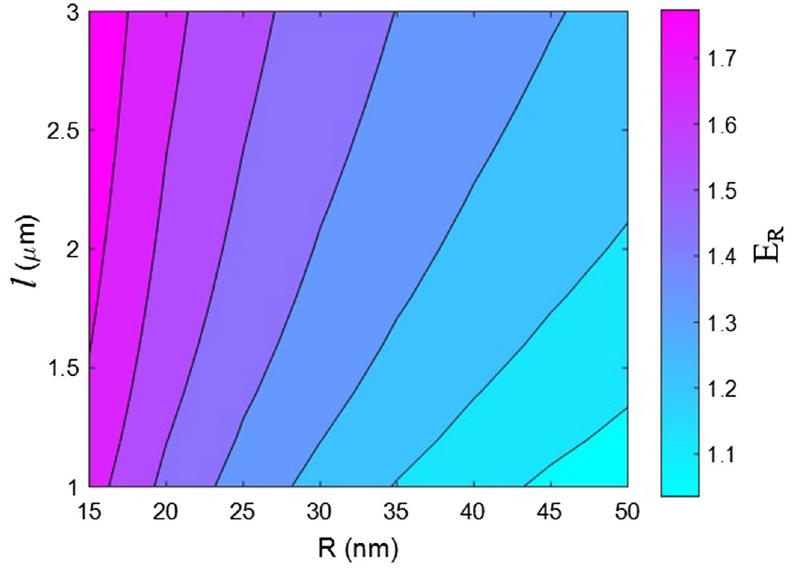
Figure 5. Effect of HNT size (radius and length) on the relative modulus according to the proposed model.